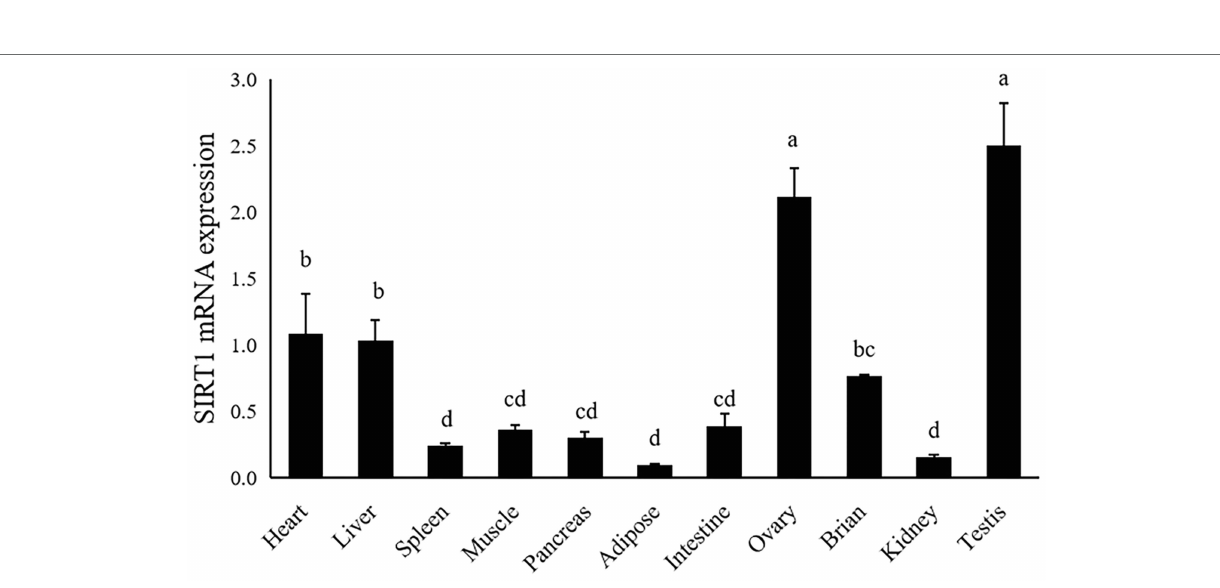
FIGURE 3 | Localization of largemouth bass SIRT1 in HEK293t cells. (A) Localization of SIRT1-EGFP fusion protein, and the cells were fixed in 4% paraformaldehyde and nuclear labeled with DAPI were observed under a fluorescence microscope. (B) Localization of SIRT1-EGFP and Lamin A-RFP fusion protein.